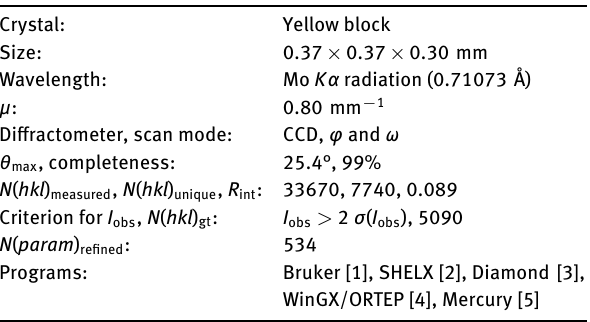
The crystal structure is shown in the figure. Tables 1 and 2 contain details on crystal structure and measurement condi- tions and a list of the atoms including atomic coordinates and displacement